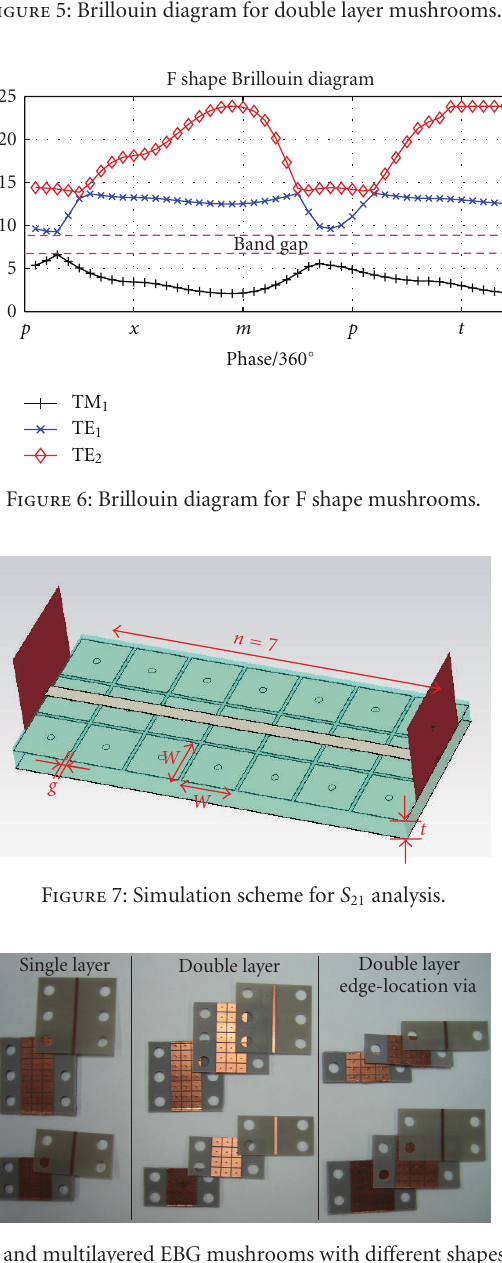
Figure 8: Samples of single and multilayered EBG mushrooms with di ff erent shapes and number of